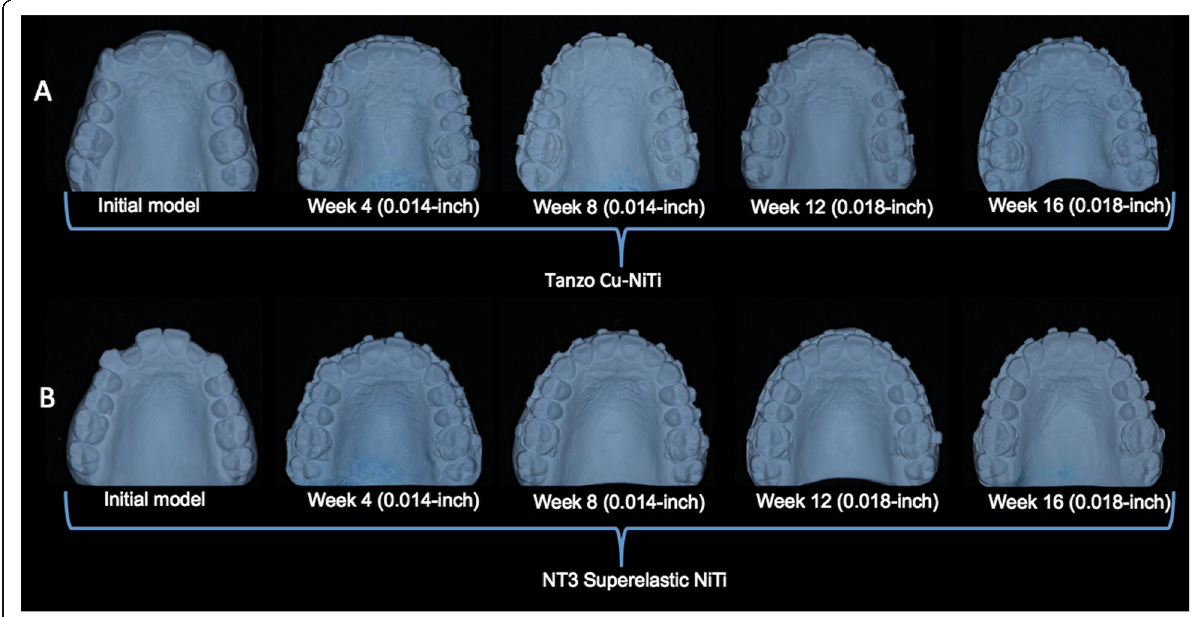
Fig. 1 a Maxillary models of a patient for group 1. b Maxillary models of a patient for group